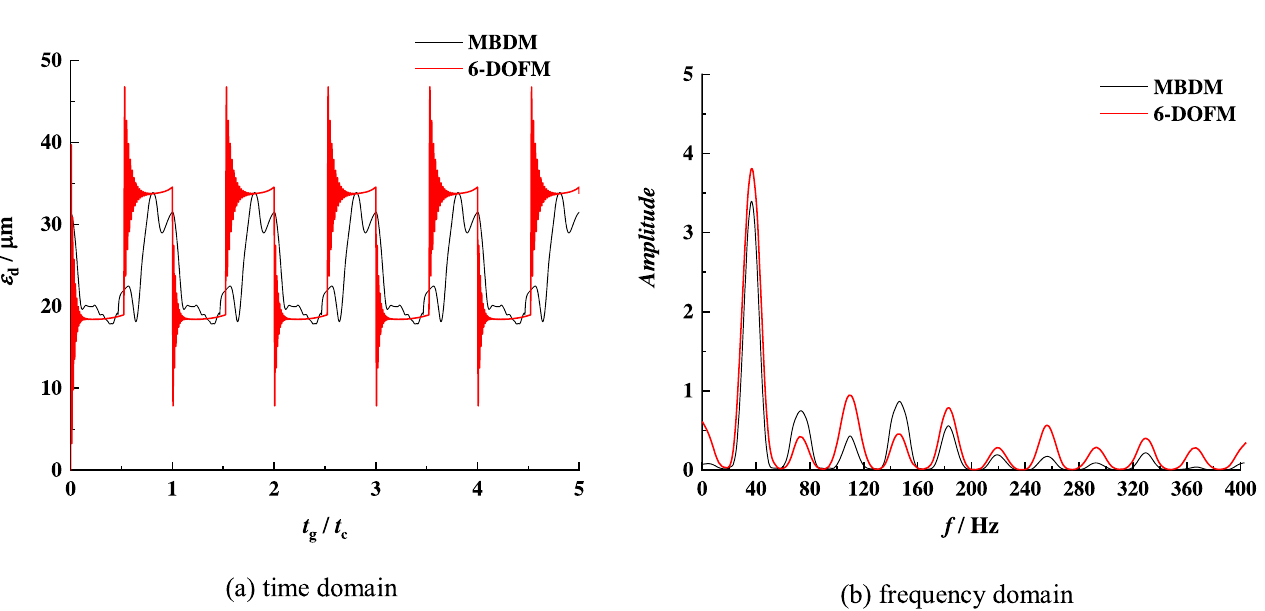
Fig. 10. Dynamic transmission error (MBDM,